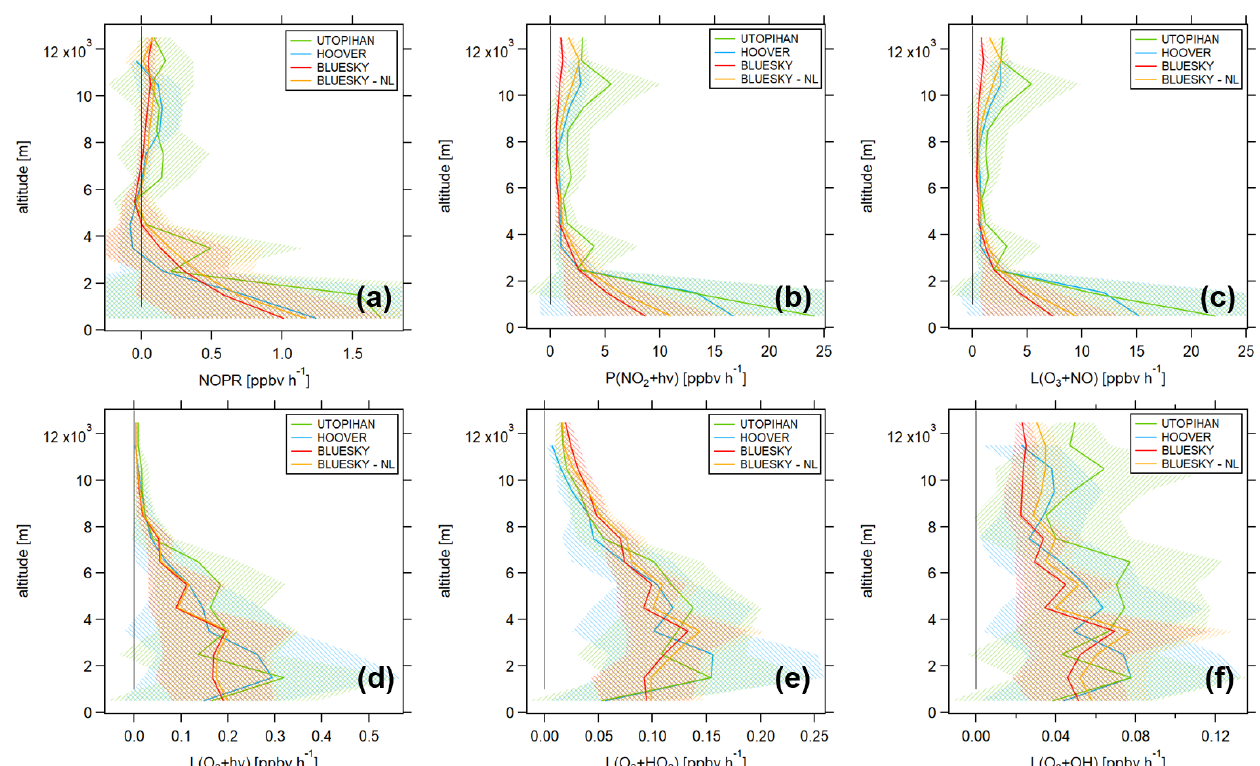
Figure 5. Vertical profiles of (a) net ozone production rates, (b) O 3 production via NO 2 photolysis, (c) O 3 loss via reaction with NO, (d) O 3 loss via photolysis, (e) O 3 loss via reaction with HO 2 and (f) O 3 loss via reaction with OH for the campaigns UTOPIHAN (green), HOOVER (blue) and BLUESKY (red) and the no-lockdown (NL) scenario (yellow). The number of data points averaged per altitude bin are displayed in Table